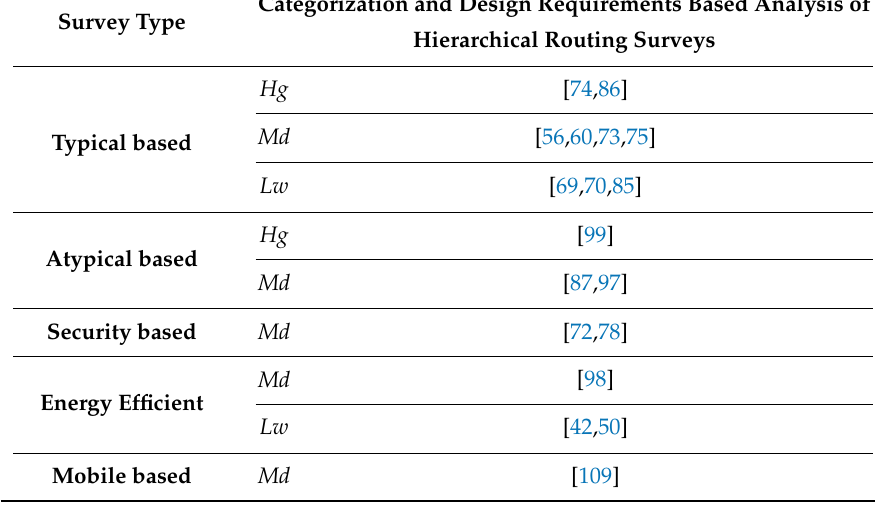
Table 4. Design Analysis of Hierarchical Routing Surveys in